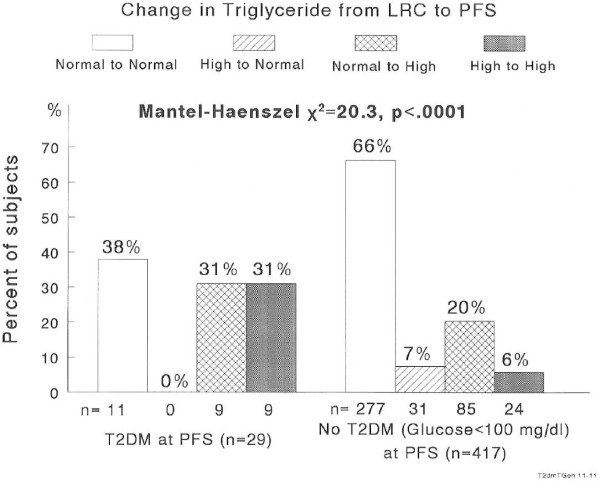
Changes in TG status groups from childhood to adulthood by adult T2DM status.